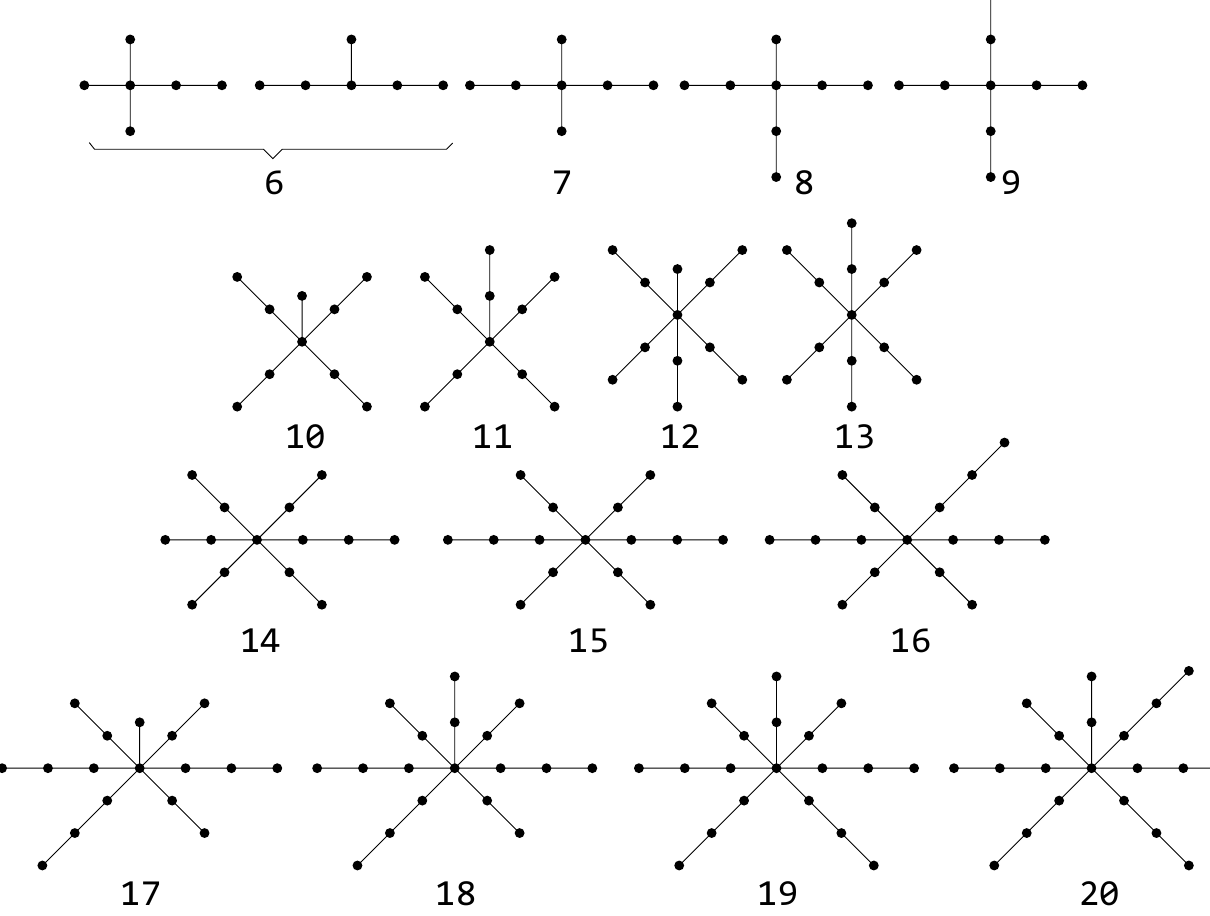
Figure 5: Trees from 6 to 20 vertices having the highest value of the Trinajsti´c index among isomeric trees.